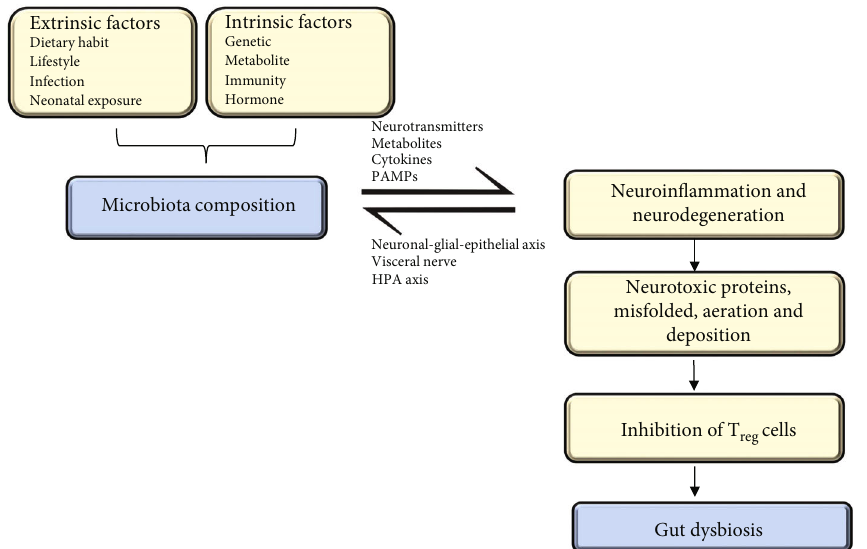
Figure 4: Role of Escherichia coli ( E. coli ): Some various ways and genes contribute to the generation of NO within the body of an organism. Among them, E. coli serves as a potent medium. Researchers have revealed that E. coli is signi fi cantly capable of converting nitrites into nitric oxides in a neutral pH